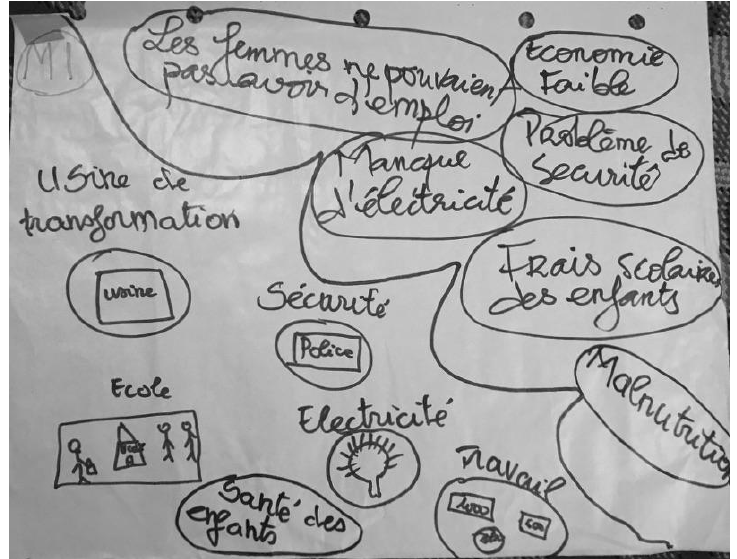
Figure 8. Example of “Before and After” Activity with Processors.